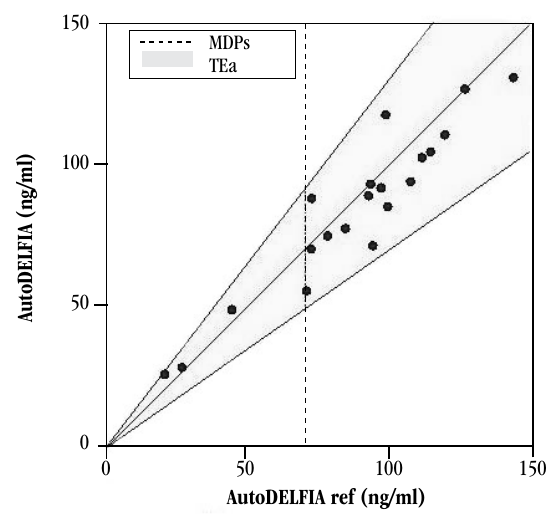
figurE – Scatter plot of AutoDELFIA comparative versus AutoDELFIA ® reference TEa: allowable total error; MDPs: medical decision